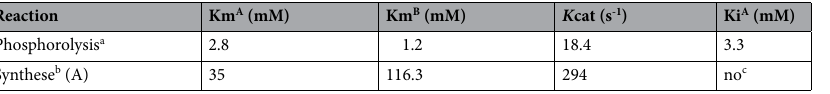
Table 2. Kinetic parameters for the reaction of Cb CBP with various substrate. a A represents cellobiose, and B represents inorganic phosphorus. b A represents D-glucose 1-phosphate, and B represents D-glucose. c Ki A value could not be calculated because there was no inhibition when the concentration of glucose reached 100 mM in the synthetic reaction.